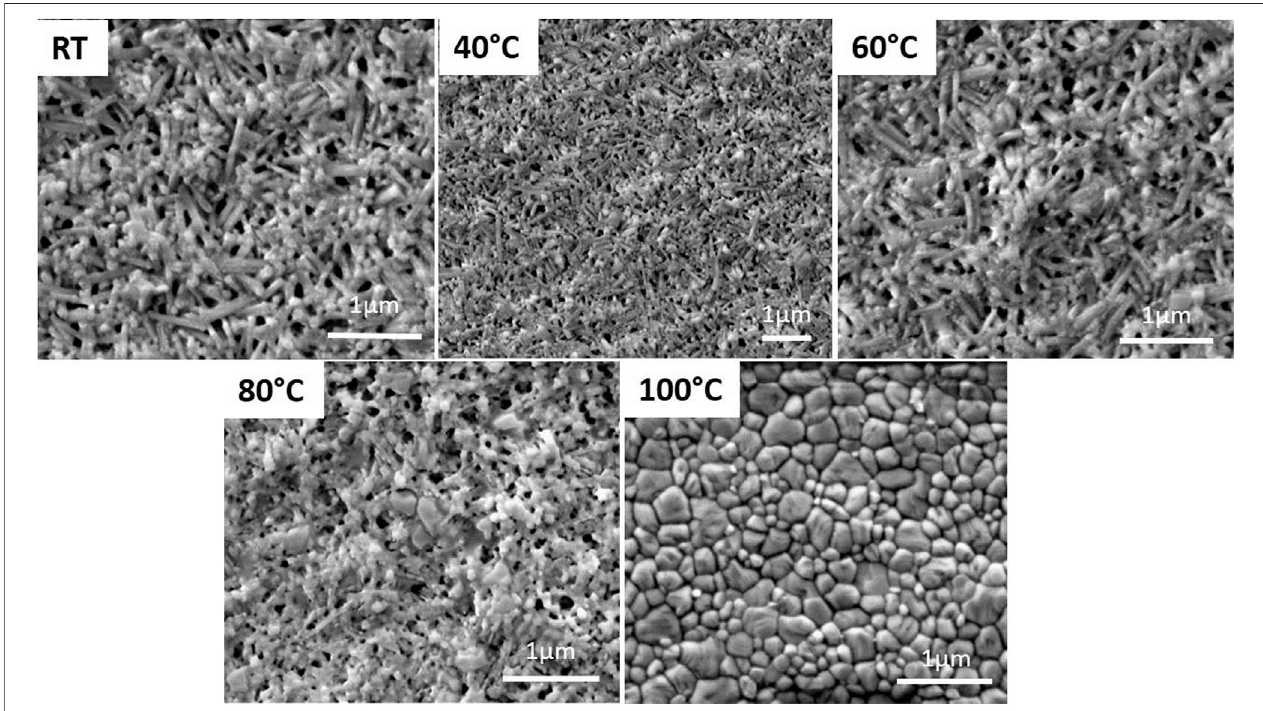
FIGURE 1 | In situ scanning electron microscopy images showing morphological transformation of MAPbI 3 fi lm at different temperatures from room-temperature (RT) to 100 ° C.